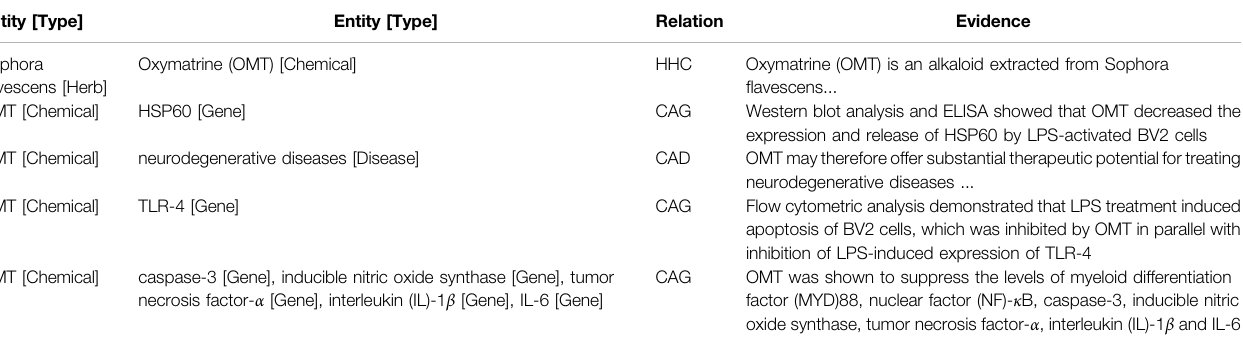
TABLE 9 | Case study: herbal-molecular knowledge extracted from an abstract (PMID27882228). Entity